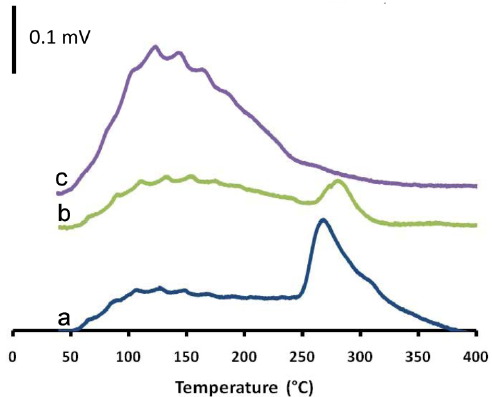
-TPD curves of (a) nano-ZnO, (b) solvent treated and calcinated nano-ZnO Figure 4. NH 3 and (c) Rh/nano-ZnO.